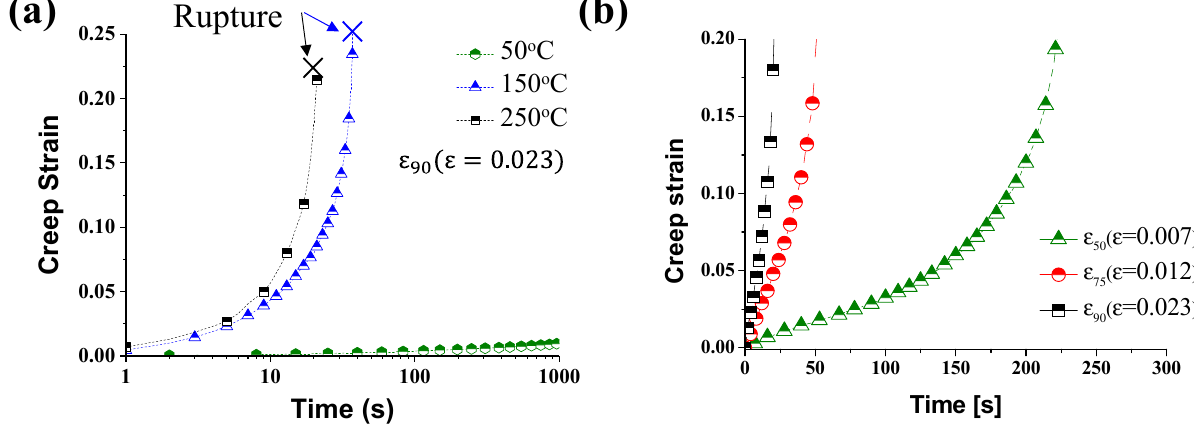
Figure 10. The creep strain–time graph according to ( a ) different temperatures at ε 90 ( ε = 0.023) and ( b ) different pre-strain at 250 ◦ C. Table 3. The time of rupture according to the pre-strain and forming temperature. The Time of Rupture